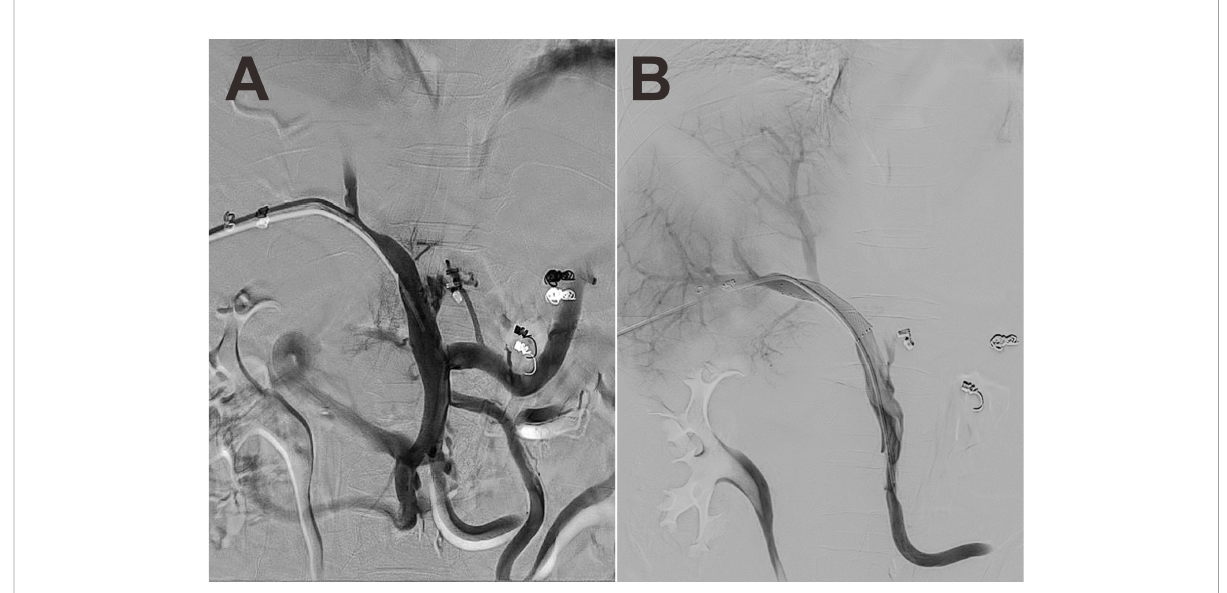
FIGURE 4 Portal venography showed severe stenosis of the portal vein at the hepatic hilum (A) . One 8-mm × 40-mm bare metal stent was placed across the stenosis, allowing rapid portal in fl ow into the liver and decompression of the large collateral varices (B)